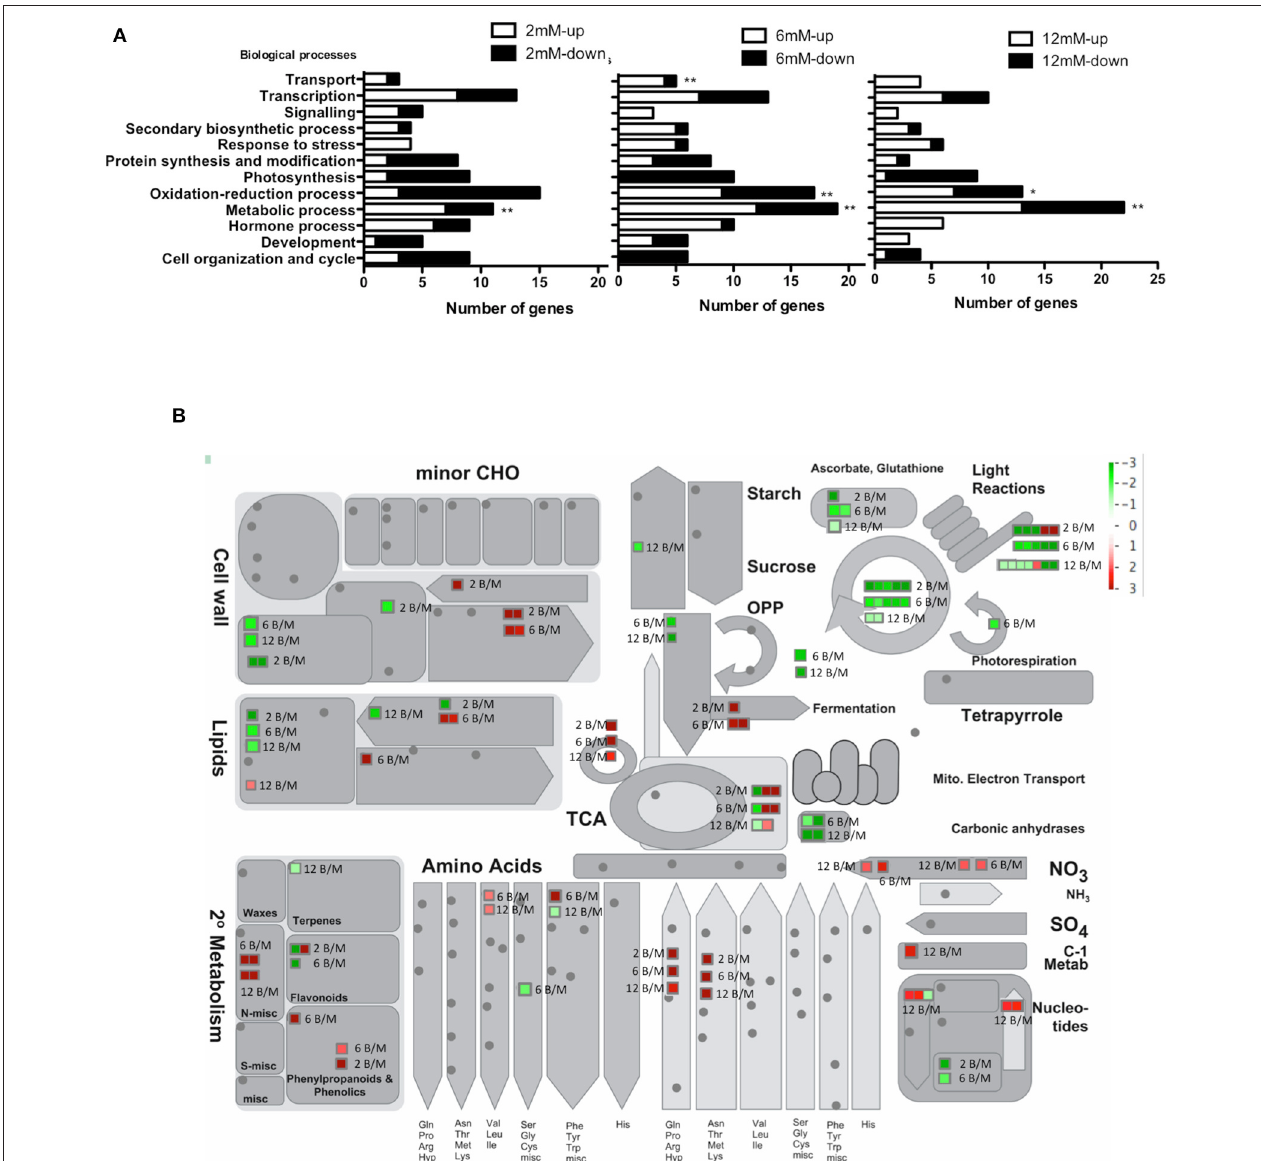
FIGURE 4 | Biological processes affected in response to B. cinerea infection under different N conditions. (A) The distribution of genes into different GO categories for biological processes is shown. The number of genes induced or repressed (in white and black, respectively) by the fungal infection depending on the N condition used relative to mock-treated plants is presented. Only genes with significant differential expression ( p < 0.05 ) were plotted, corresponding to 132, 151, and 103 genes (2, 6, and 12mM nitrate, respectively). Overrepresented categories compared to the entire set on the Tomato genome array are indicated with asterisks ( ** p < 0.01 , * p < 0.05 ). (B) MapMan software was used to provide a snapshot of modulated genes over the main metabolic pathways. DEGs were binned to MapMan functional categories and Log2 fold changes values for each gene upon B. cinerea infection referred to mock-treated samples are represented (B/M in 2mM, 6mM, and 12mM nitrate). Up-regulated and down-regulated transcripts are shown in red and green,